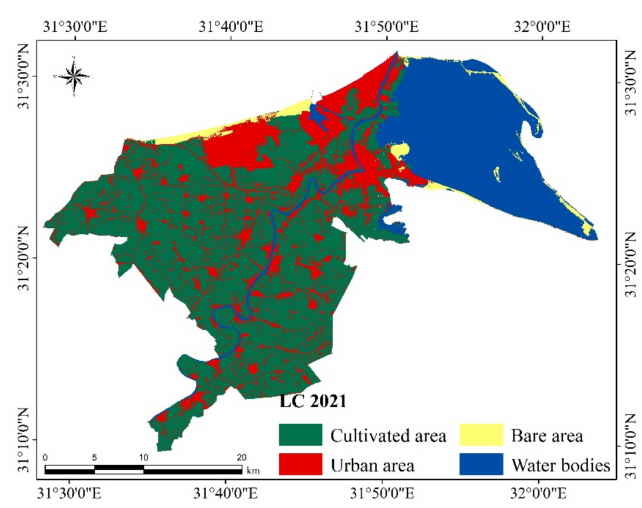
Figure 6. LULC of Damietta governorate at 2021.